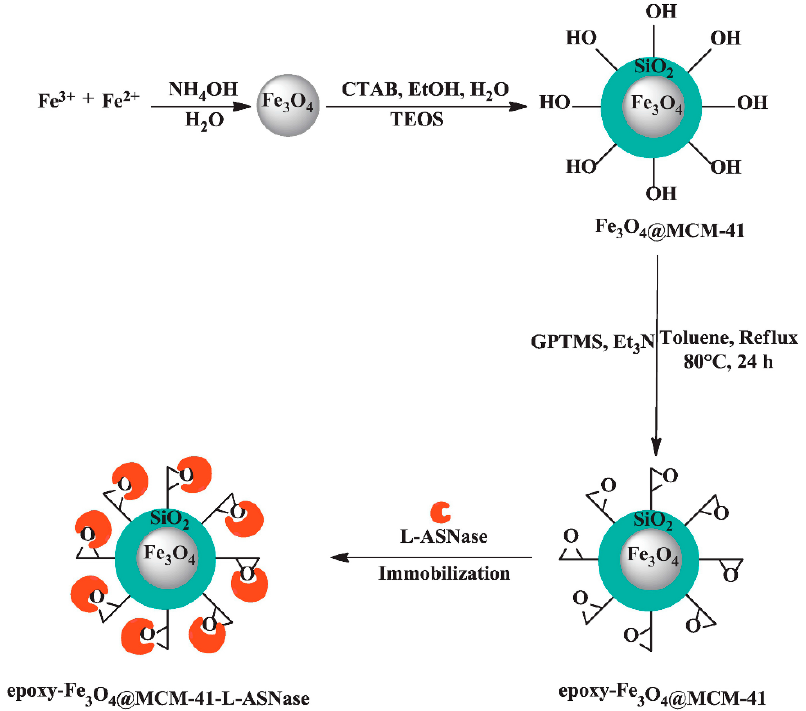
Figure 69. Schematic depiction of magnetic Fe 3 O 4 @MCM-41 sieves preparation, epoxy modification and L-ASNase immobilization. Reproduced with permission from [175]. Copyright 2018 Elsevier B.V.